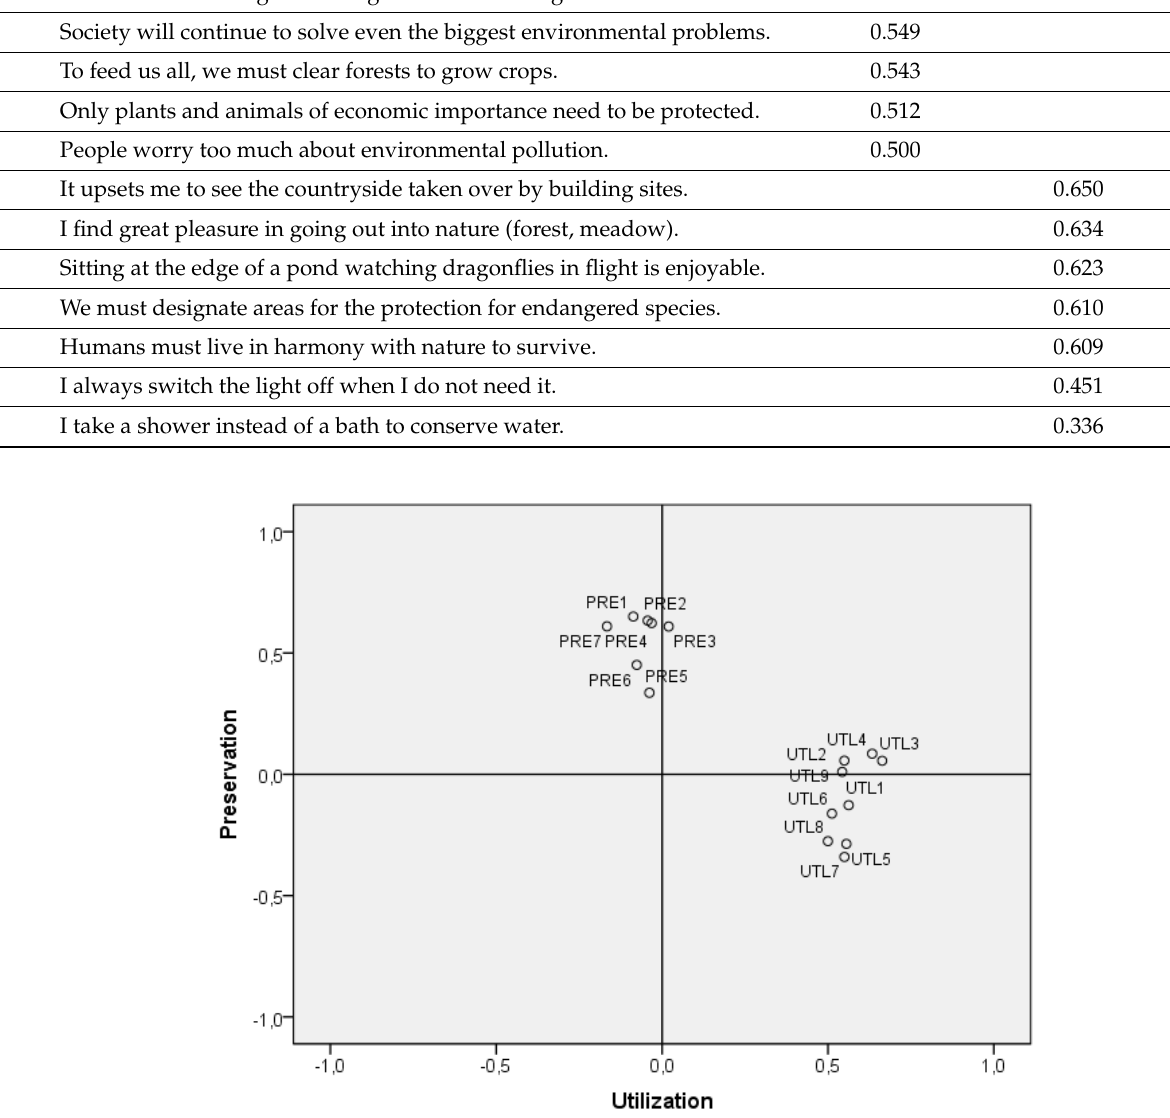
UTL3 Our planet has unlimited resources (e.g., potable water, coal, or oil). UTL4 Nature is always able to restore itself.